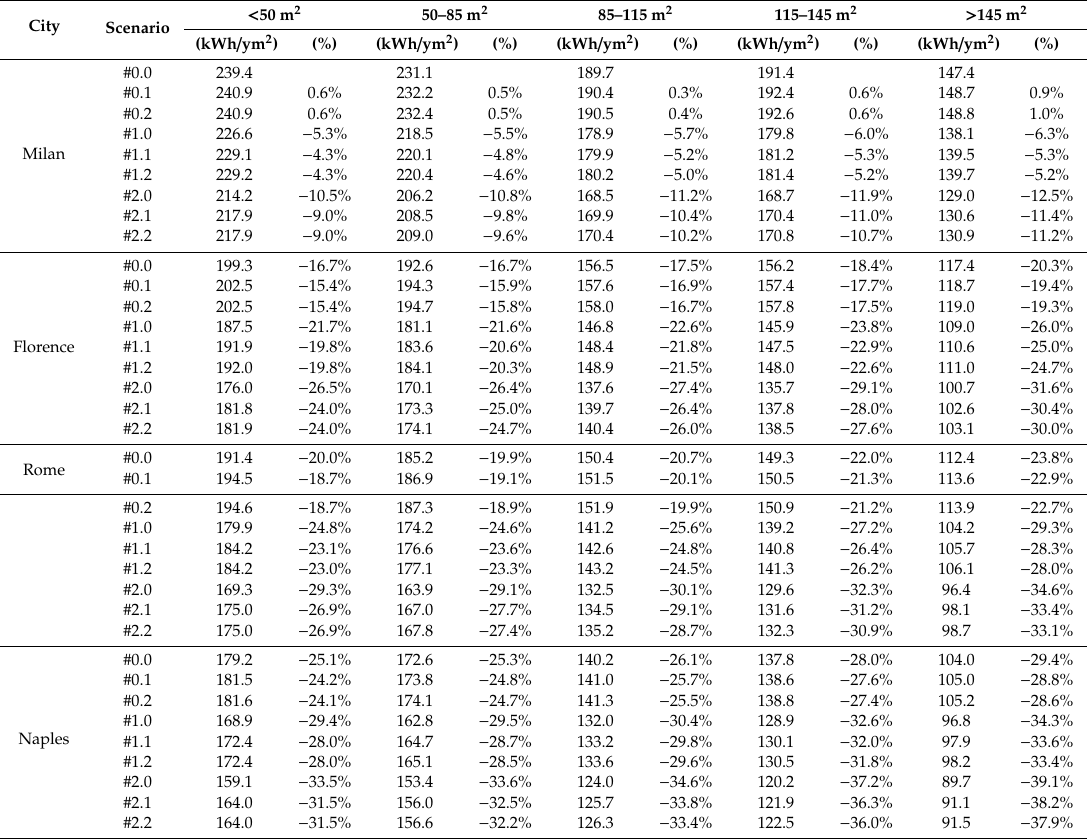
Table 3. Summary of specific primary energy consumption for all simulated